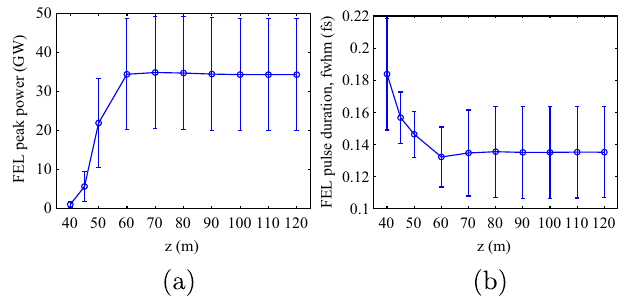
FIG. 10. FEL peak power (a) and pulse duration (b) along the undulator. The L2 rf phase is − 35 . 3 °, and the undulator is tapered at Δ K=K ¼ − 1% from 20 to 132